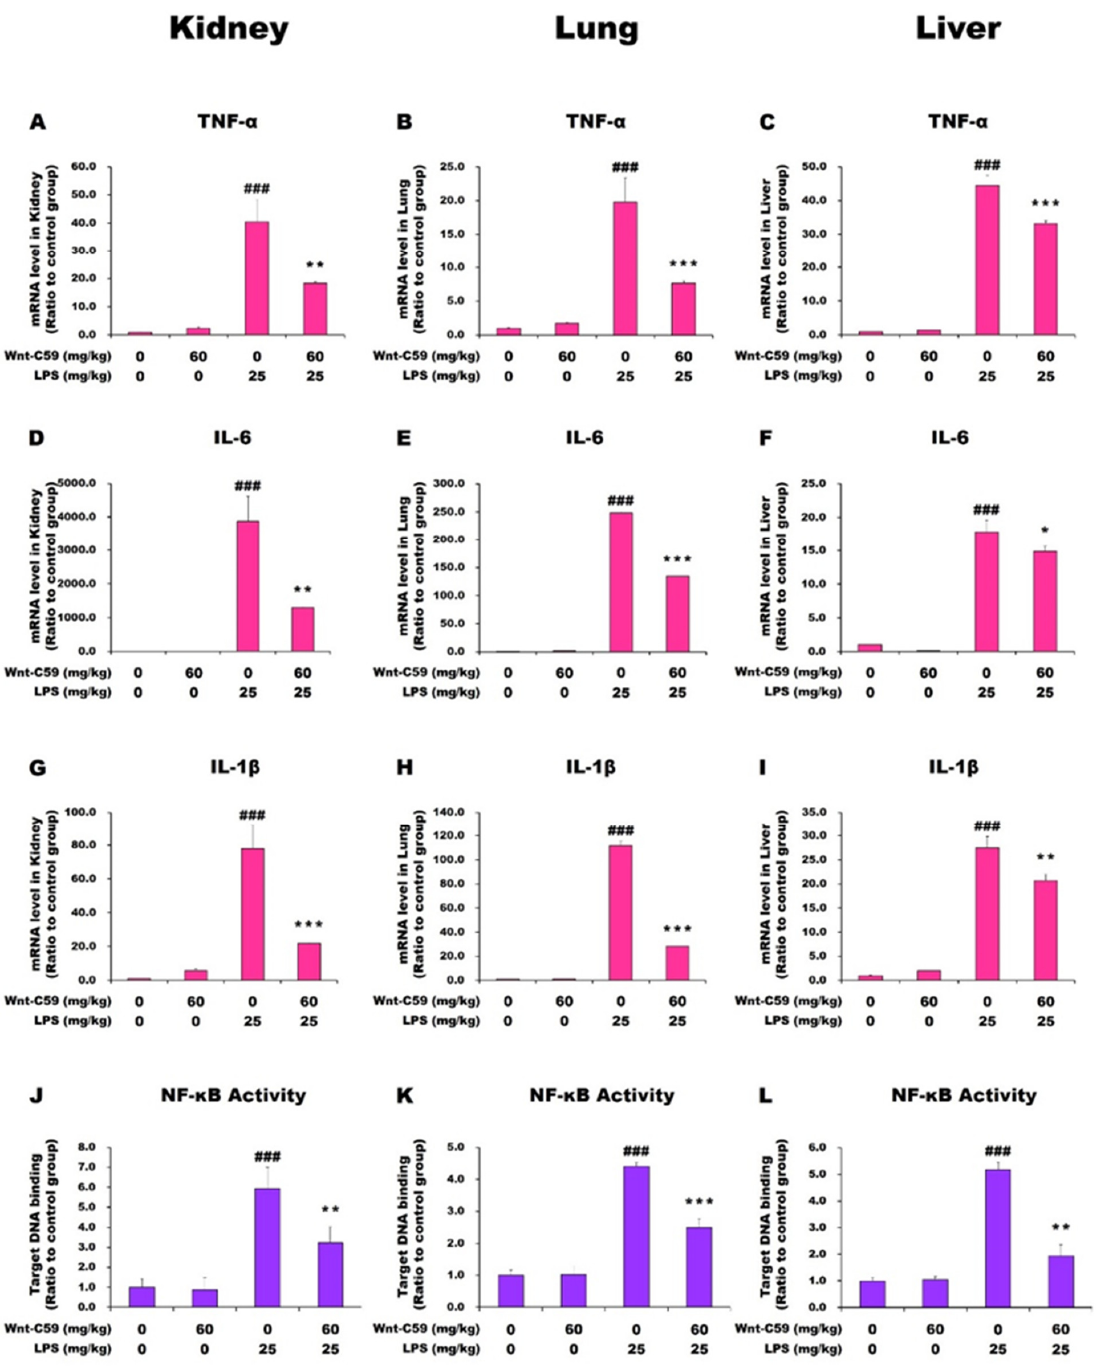
Figure 2. Wnt-C59 suppressed the cytokine upregulation and NF- κ B activity in multiple organs of endotoxemic mice. C57BL/6 mice were i. p. injected with 0 or 60 mg/kg of Wnt-C59 and then with 0 or 25 mg/kg of lipopolysaccharide (LPS) after 2 h. ( A – I ) The cytokine mRNA levels in the kidney, lung, and liver were quantified via reverse transcription– quantitative polymerase chain reaction ( n = 4). ( J – L ) The target-DNA binding activity of NF- κ B in the kidney, lung, and liver was measured using ELISA ( n = 4). * p < 0.05, ** p < 0.01, and *** p < 0.001 compared with the group injected with 25 mg/kg of LPS. ### p < 0.001 compared with the control group (unpaired t -test).